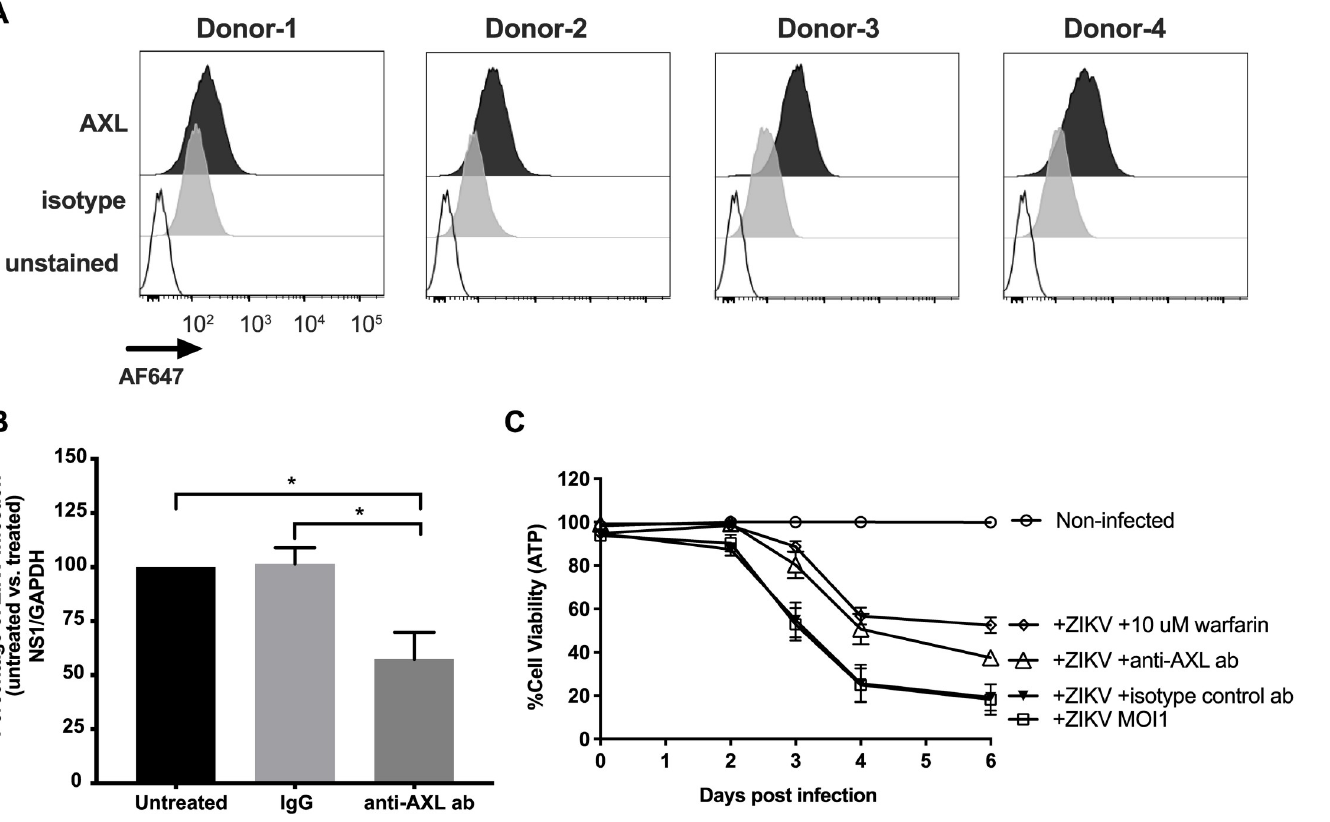
Fig 3. AXL antibody decreases ZIKV infection. (A) fcMSCs (donors 1–4) were stained with either isotype control or anti-AXL-APC antibodies as indicated on the panel and AXL expression was evaluated using flow cytometry. (B) fcMSCs were pre-treated with AXL blocking antibody or isotype control for 1 h and infected with MOI 1 of ZIKV for 6 h. Assessment of ZIKV replication in fcMSCs was performed by qRT-PCR quantification of NS1 mRNA levels 48 h post-infection. (C) fcMSCs were pre- treated with anti-AXL antibody (10 μ g/mL), isotype control antibody, or warfarin and infected for 1 h prior to infection with 1 MOI ZIKV for 6 h, maintaining pre- treatment throughout duration, and cell viability was assessed at the indicated time points post-infection using the CellTiter-Glo Luminescent Cell Viability Assay.